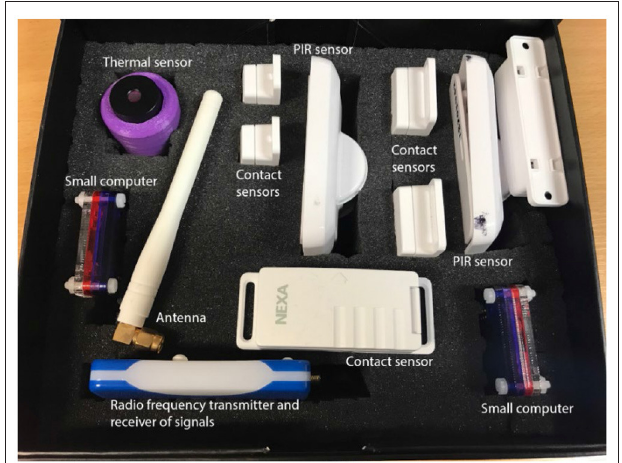
FIGURE 1 | Sensors included in the PCRC SHIB kit.